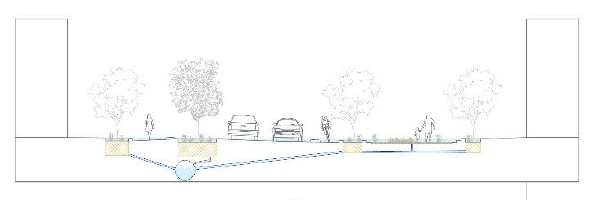
Figure 3: Shows an example of street reconfiguration, re- distributing the existing space to increase stormwater detention capacity within the streetscape. Image credit Anna Müeller